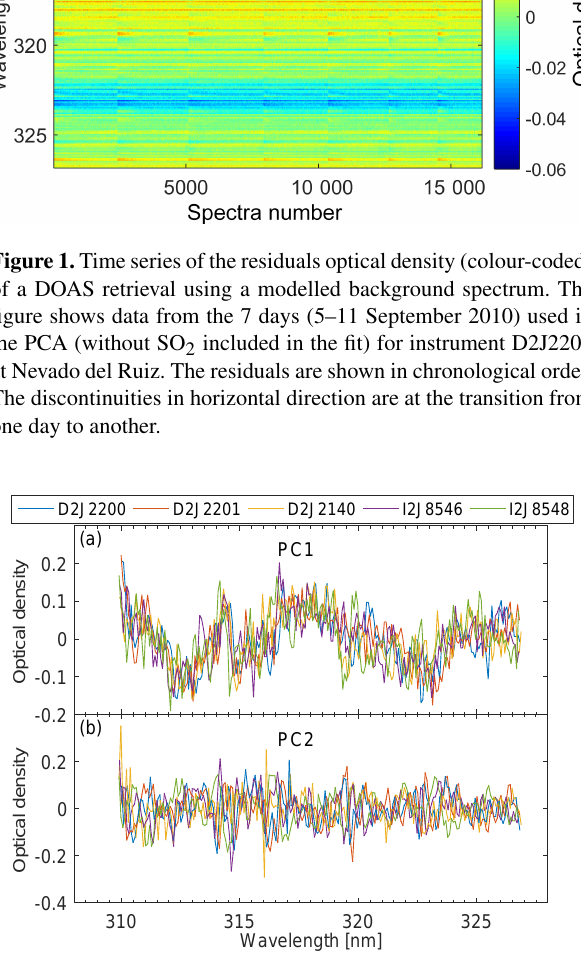
Figure 2. The first two principal components that were included in the solar atlas evaluation shown for all five instruments at Nevado del Ruiz and Tungurahua. For Tungurahua the principal compo- nents from 2010 are